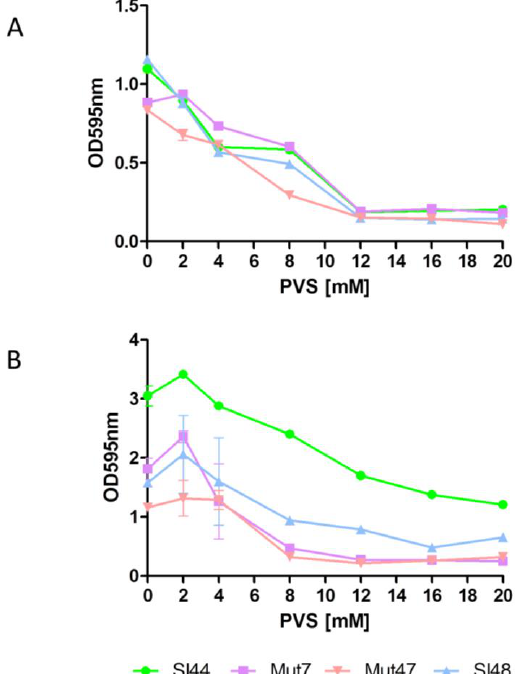
Figure 8. Effect of PVS on binding of S. lugdunensis to Fn- ( A ) or Fg- ( B ) coated wells. Overnight cultures were diluted to an OD 595 of 0.01. 180 µL of diluted culture were mixed with 20 µL of concentrated phenyl vinyl sulfone (PVS) to the respective concentrations in a microtiter plate well. Plates were incubated at room temperature for 1 h. Adherence was determined in a Biorad reader at absorbance of 595 nm. Data are presented as mean adsorptions of triplicate determinations. Single representative experiments out of three are presented. Error bars show standard deviations (SD).